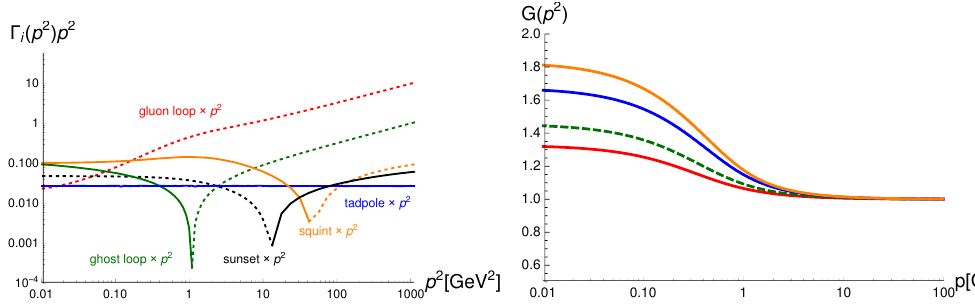
Figure 5. Left: Contributions of single diagrams to the gluon dressing function. Right: Family of solutions for the ghost dressing function obtained using di (cid:11) erent conditions for the gluon propagator in the